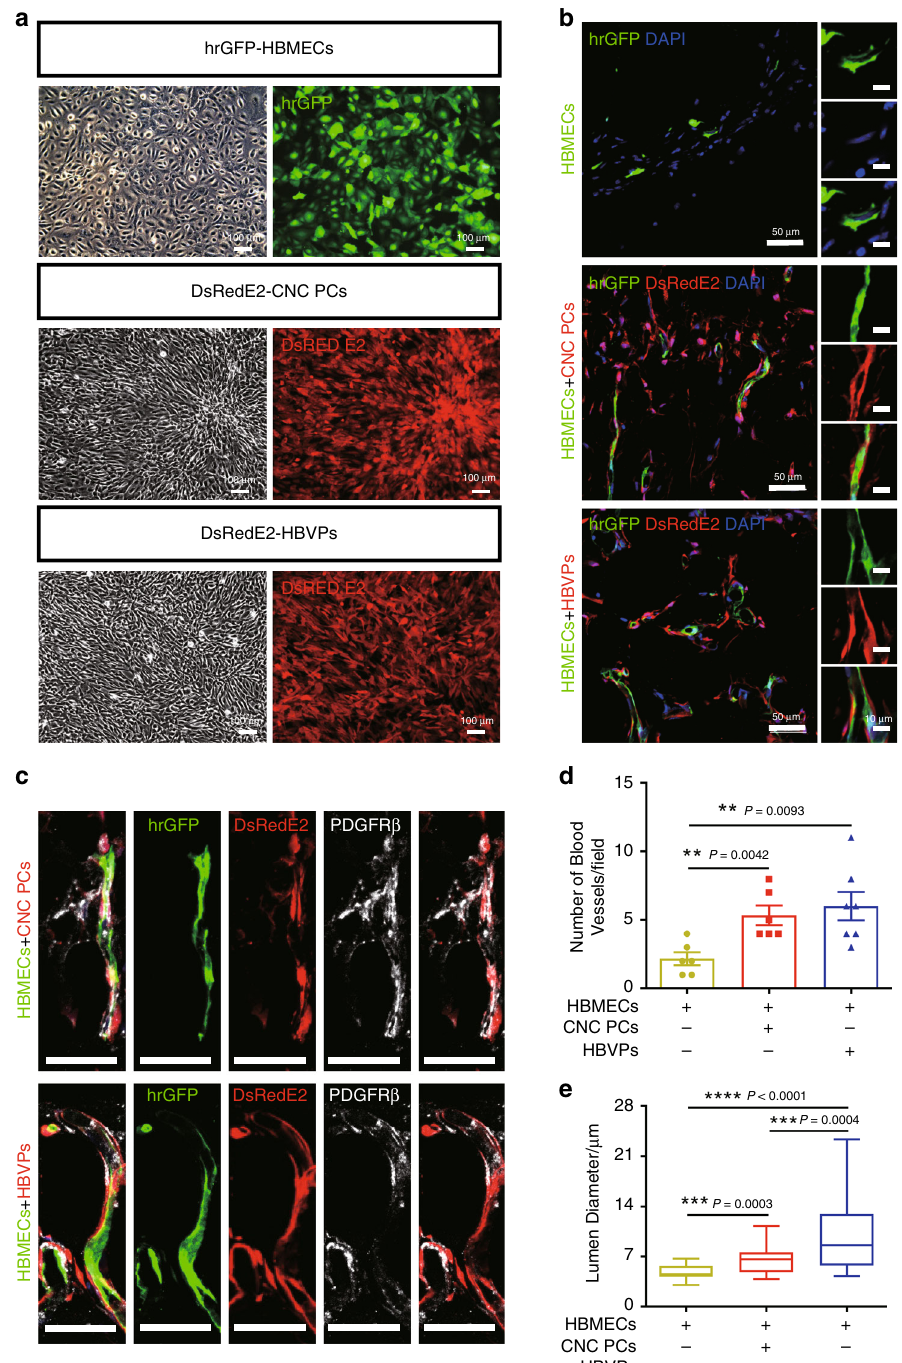
Fig. 4 Matrigel plug assay shows the capacity of hPSC-CNC PCs to support the vasculature formation in vivo. a DsRedE2-expressing hPSC-CNC PCs/ HBVPs and hrGFP-HBMECs were generated and used for the in vivo Matrigel plug assay. Scale bar: 100 μ m. b The localization of DsRedE2-hPSC-CNC PCs and DsRedE2-HBVPs was observed under a fl uorescence microscope. Scale bar: 50 μ m (left panel) and 10 μ m (right panel). c The expression of PDGFR β in transplanted hPSC-CNC PCs and HBVPs was detected by immuno fl uorescence assay. Scale bar: 50 μ m. d The numbers of blood vessels formed in different groups were counted. e The vessel diameter of different groups was quanti fi ed. Graphs represent the individual data points, the mean ± SEM of three independent experiments. Micrographs are representative of n = 3 biological replicates. P- value (* P < 0.05, ** P < 0.01, *** P < 0.001, **** P < 0.0001) was calculated by two-tailed unpaired Student ’ s t -test. Source data are provided as a Source Data fi